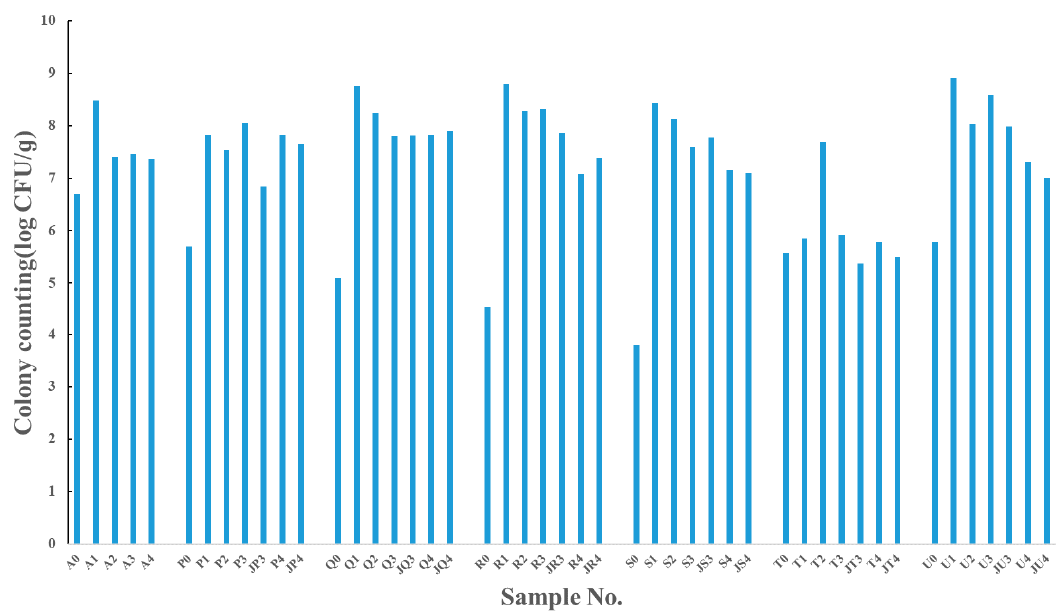
Figure 1. Cultured bacterial colonies counting under different antibiotic exposure. Table 2. The number of isolates and taxonomic composition of culturable bacteria. Sample